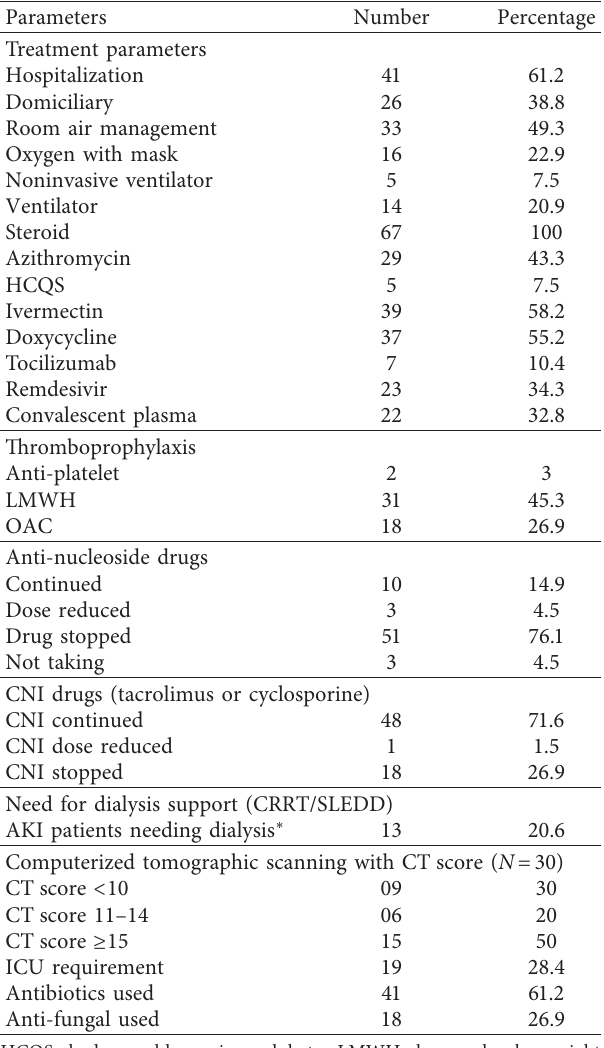
Table 3: Management and treatment administered in kidney transplant recipients with